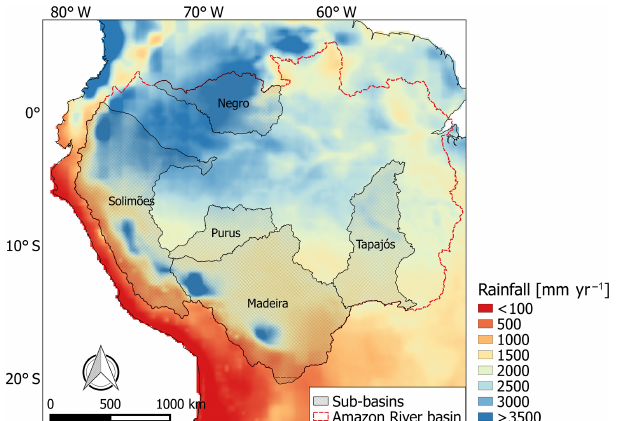
Figure 1. Amazon River sub-basins assessed in this study. The background map shows the mean annual rainfall 2001–2014, mea- sured by the Tropical Rainfall Measuring Mission (TRMM). The extents of five sub-basins analysed here are indicated on the map with solid black lines and shading. The solid red line indicates the boundary of the entire Amazon River